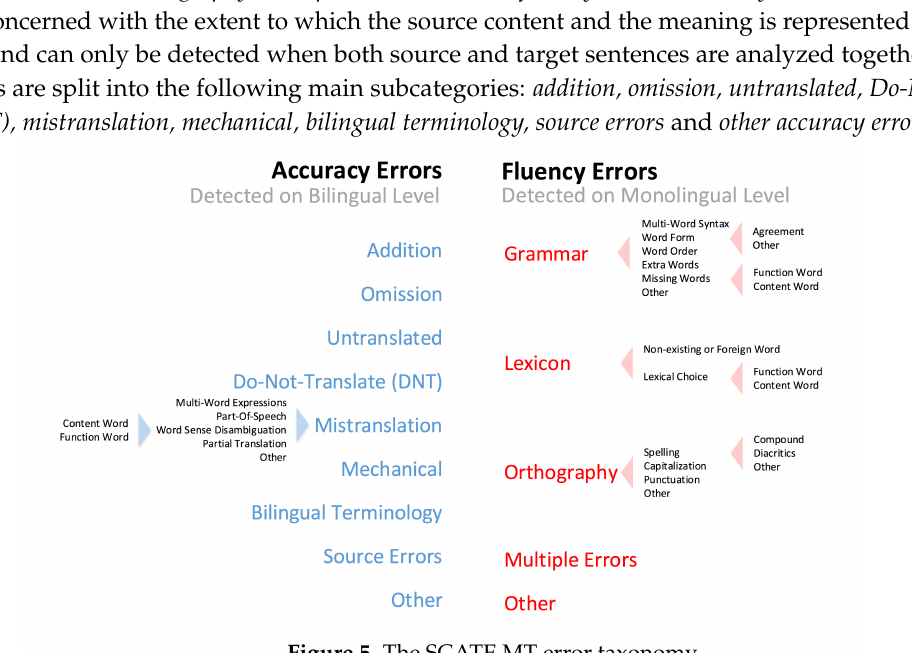
Figure 5. The SCATE MT error